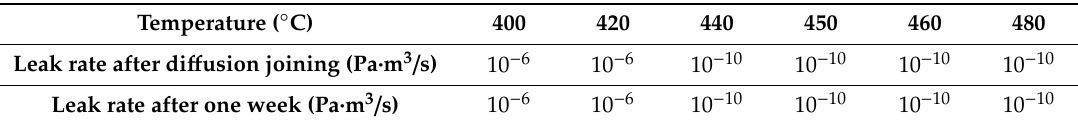
Table 2. Gas tightness of di ff usion joints bonded by liquid gallium with nano-copper particles at di ff erent temperatures.